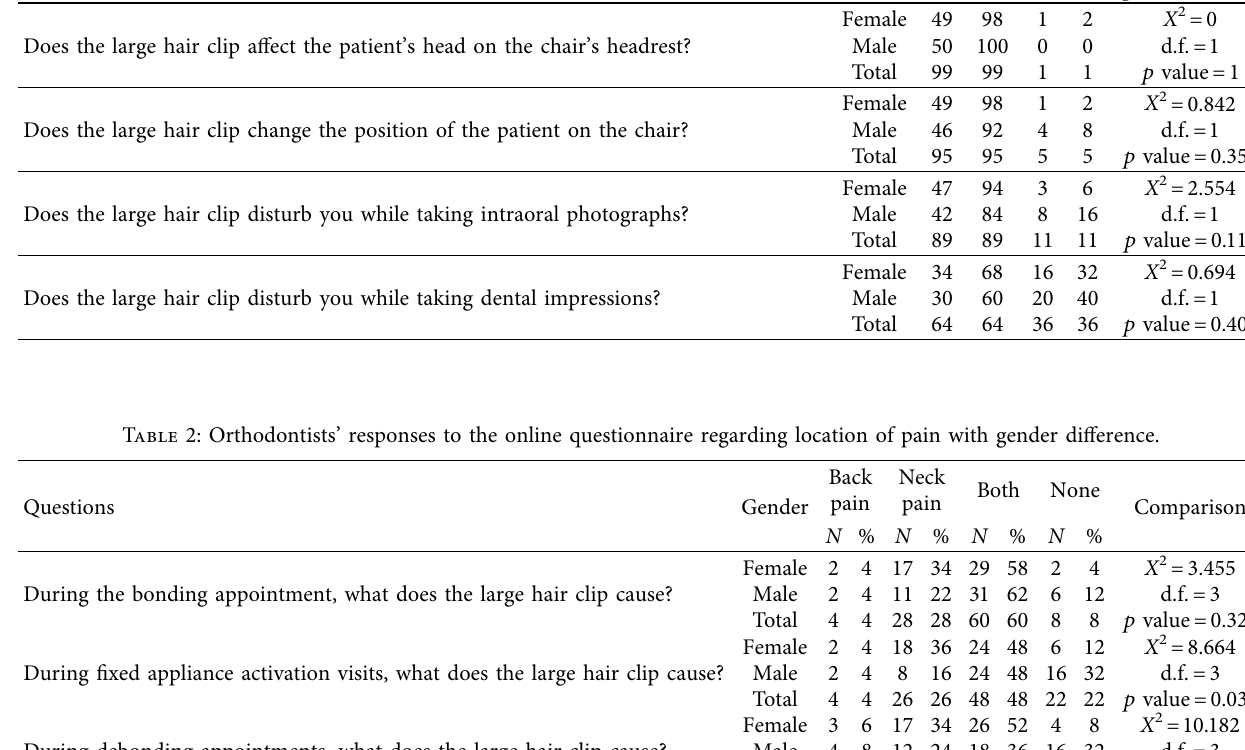
When you see a patient for the first time, do you get bothered by the large hair clip?